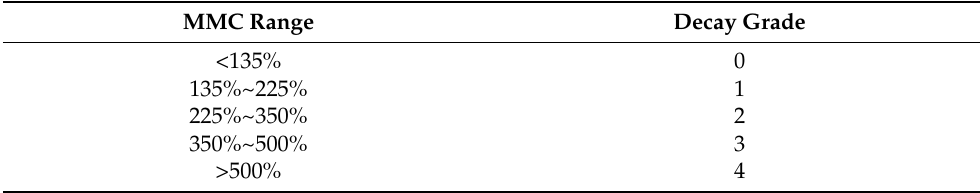
Table 3. De Jong’s deterioration state